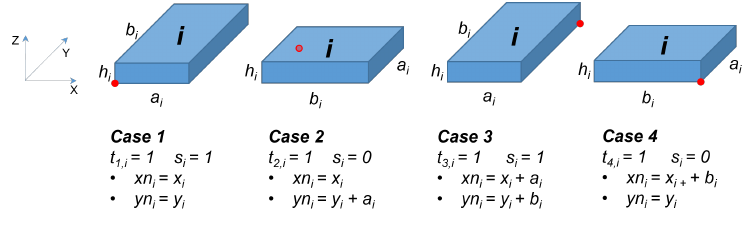
Figure 4. Links between FLB corner and node